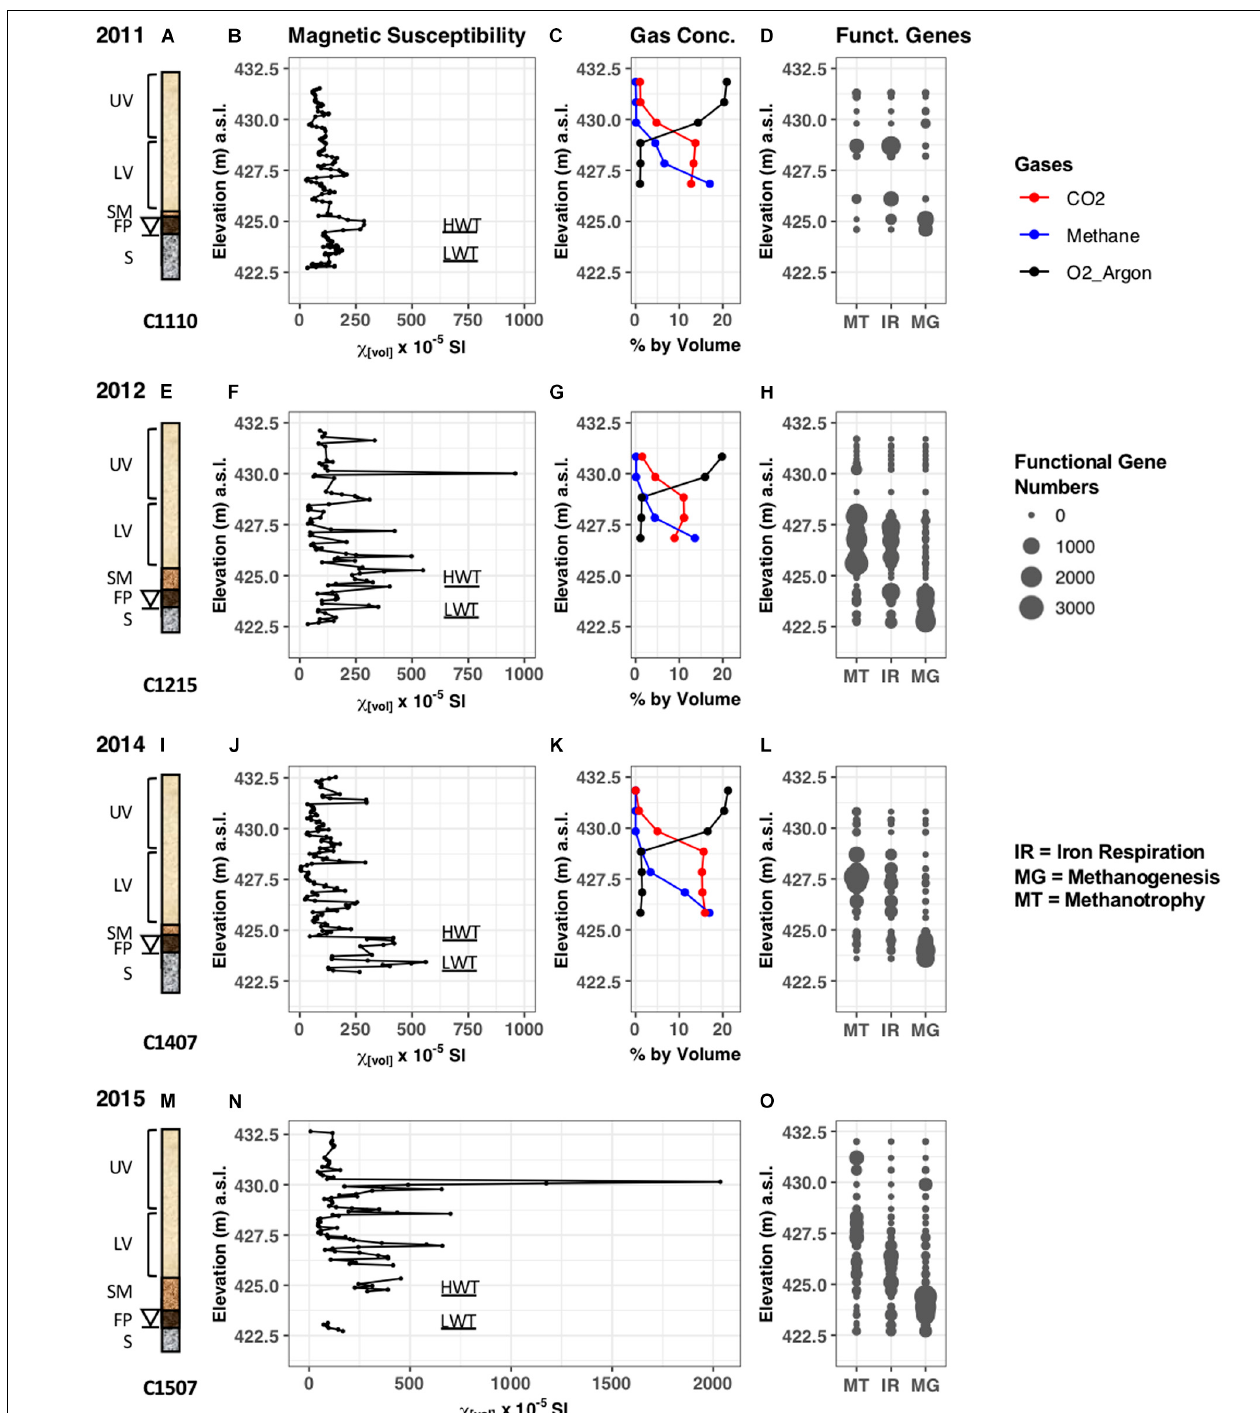
FIGURE 2 | Data collected pertaining to the cores retrieved in years 2011, 2012, 2014, and 2015. (A,E,I,M) Schematic drawing of the cores C1110, C1215, C1407, and C1507 retrieved from the north oil pool. The elevations of the smear zone, free-phase product, and saturated zone vary year to year due to the fluctuating water table (denoted by a triangle). UV, upper vadose zone; LV, lower vadose zone; SM, smear zone; FP, free-phase oil zone; S, saturated zone; HWT, high water table; LWT, low water table. (B,F,J,N) Magnetic susceptibility of sediments acquired in the years 2011, 2012, 2014, and 2015. (C,G,K) Gas concentrations (in % by volume) in well 601G measured in 2011, 2012, and 2014. (D,H,L,O) Predicted number of functional genes in the samples identified by PICRUSt. MT, Methanotrophy; IR, Iron respiration; MG, Methanogenesis.